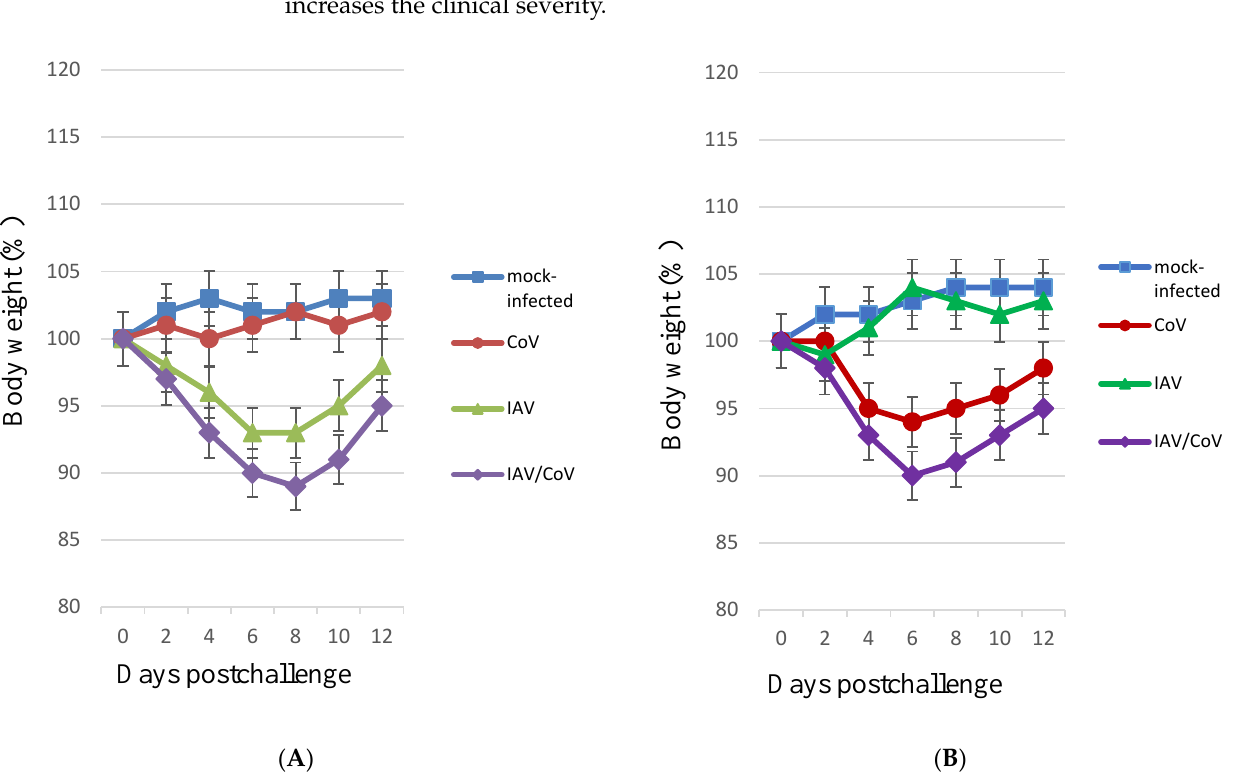
Figure 4. Body weight changes in monoinfected and coinfected with IAV and SARS-CoV-2 animals . ( A ) Body weight changes in monoinfected and coinfected with IAV and SARS-CoV-2 ferrets . “CoV (SARS-CoV-2) ”— on Day 0, the ferrets were intranasally challenged with SARS-CoV-2 (3 × 10 5 TCID 50 ); “IAV”— on Day 0, the ferrets were intranasally challenged with IAV (10 2 TCID 50 ); “IAV/CoV”— on Day 0, the ferrets preinfected (2 days earlier) with IAV (10 2 TCID 50 ) were intranasally challenged with SARS-CoV-2 (3 × 10 5 TCID 50 ); “mock-infected”—on Day 0, the ferrets were intranasally inoculated with PBS. n = 4. ( B ) Body weight changes in monoinfected and coinfected with IAV and SARS-CoV-2 hamsters. “CoV SARS-CoV-2)”—on Day 0, the hamsters were intranasally challenged with SARS-CoV-2 (10 4 TCID 50 ); “IAV”— on Day 0, the hamsters were intranasally challenged with IAV (2 × 10 3 TCID 50 ); “IAV/CoV”— on Day 0, the hamsters preinfected (4 days ear- lier) with IAV (2 × 10 3 TCID 50 ) were intranasally challenged with SARS-CoV-2 (10 4 TCID 50 ); “mock - infected”— on Day 0, the hamsters were intranasally inoculated with PBS. n = 8 at 0 dpi to 6 dpi; n = 4 at 7 dpi to 12 dpi, as 4 animals were sacrificed. The values represent the means ± SDs of individual animals. Student’s t -test was used for two-group comparisons. * p < 0.05.